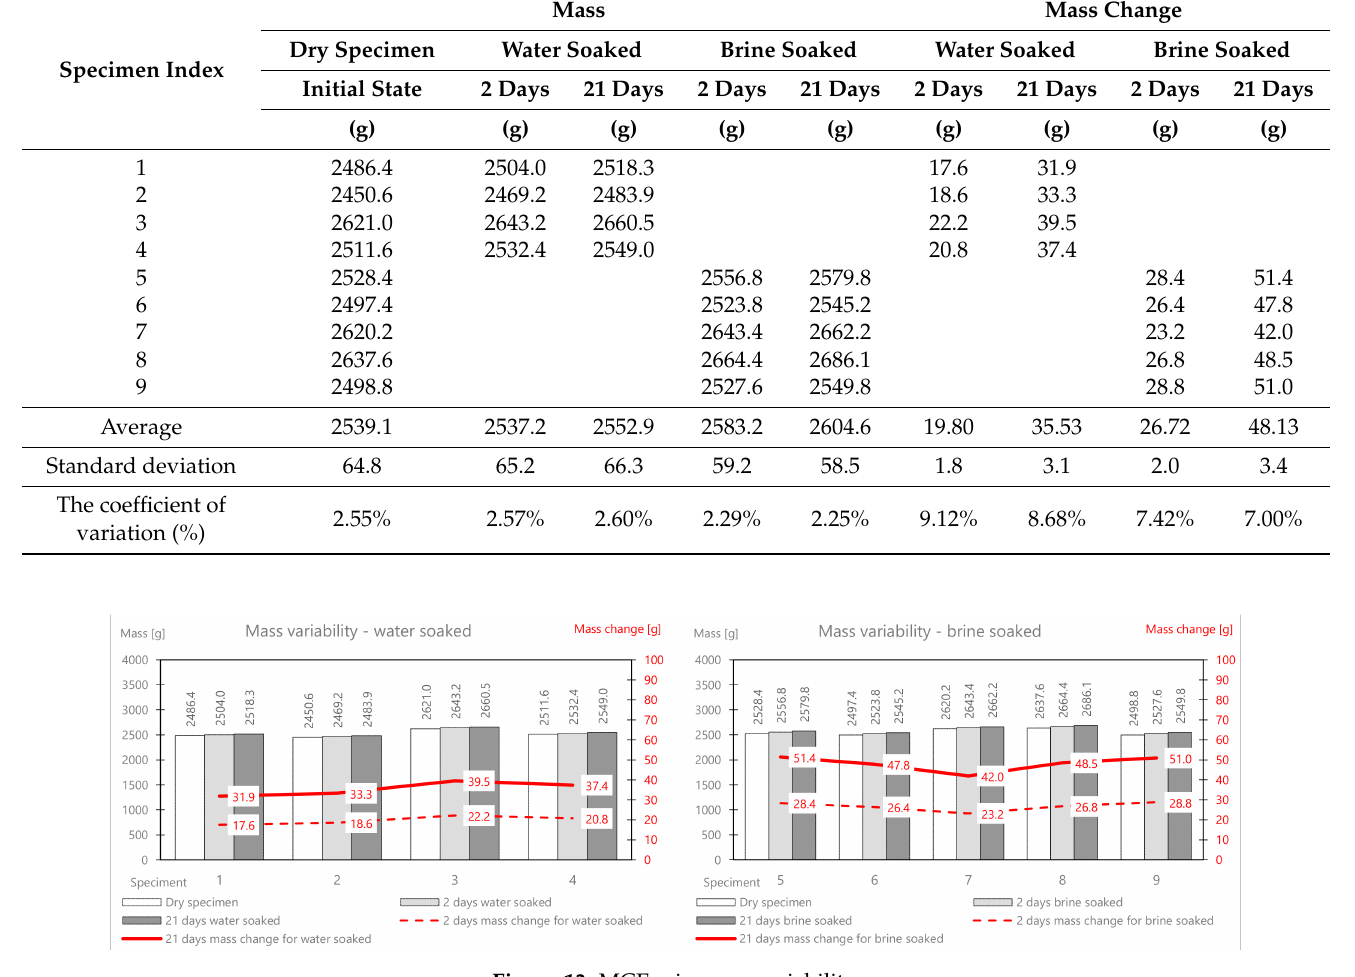
Figure 13. MCE mix mass variability. Table 12. MCE mix stiffness variation via water and brine